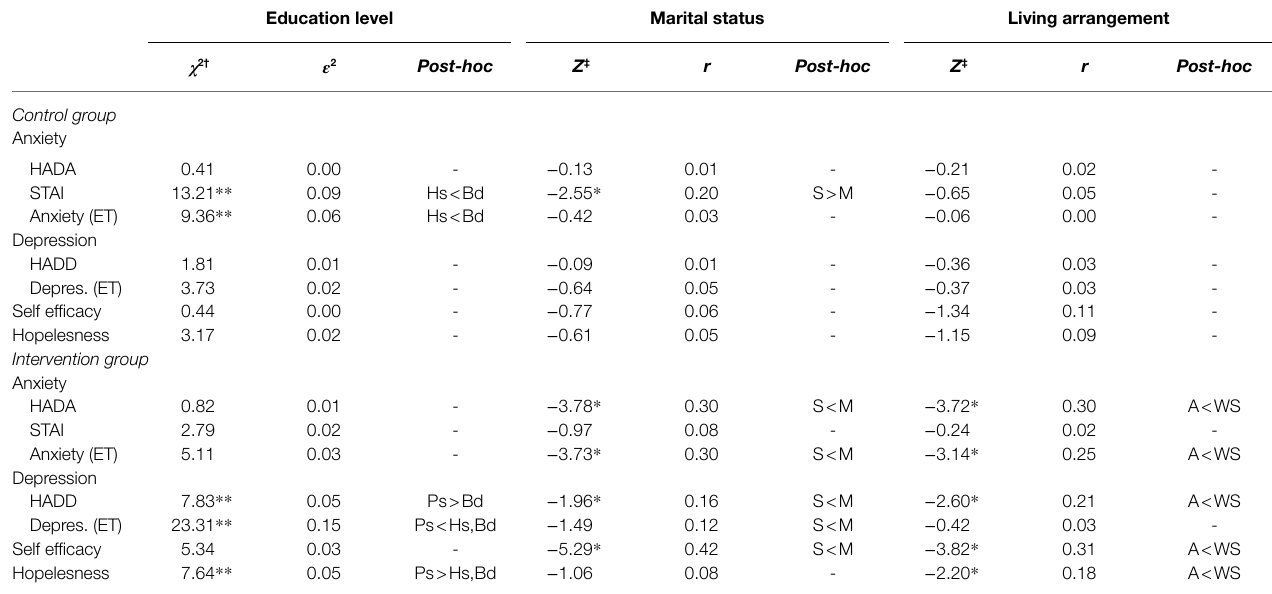
TABLE 5 | The impact of demographic variables “a” on anxiety and depression scores, self-efficacy, and hopefulness. Education